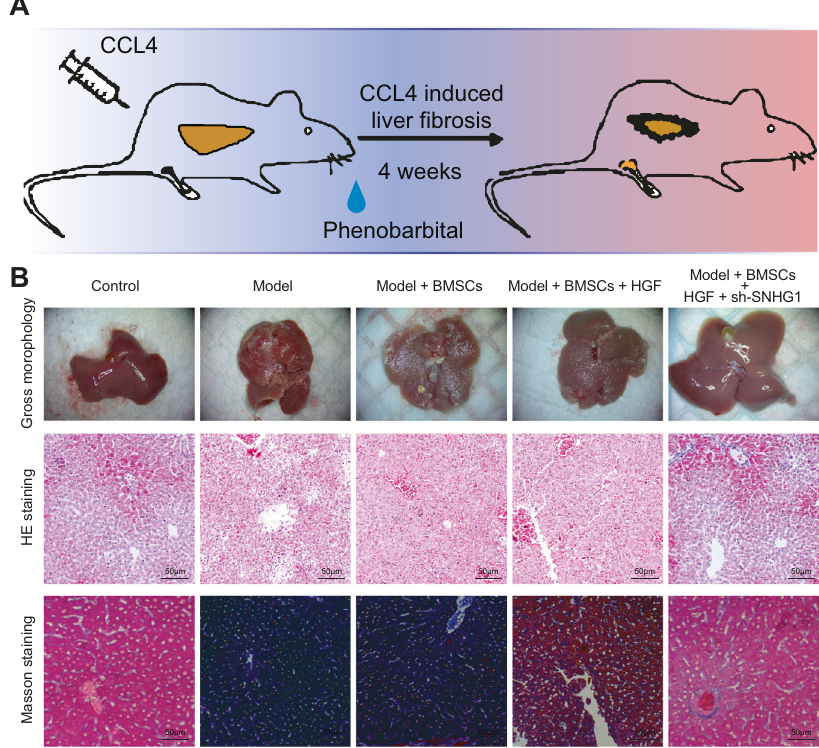
Fig. 3 HGF-induced BMSCs silencing lncRNA SNHG1 attenuates cirrhosis in mice. A Schematic representation of mouse cirrhosis model establishment. B Liver gross observation, HE staining and Masson ’ s staining to detect liver morphology, liver cell necrosis, pseudolobule, and liver fi brosis in normal mice, cirrhotic mice, and treated mice. N = 6 mice/group.